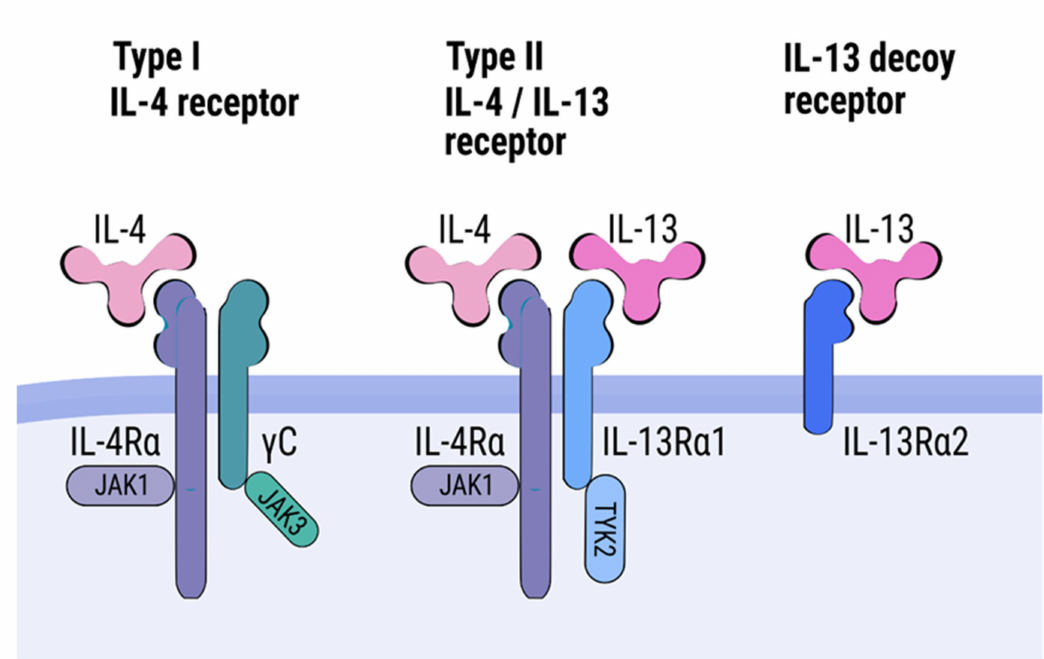
Figure 1. IL-4 receptor alpha (IL-4R α ) constitutes subunits of two heterodimeric receptors, named type I and type II receptors. The type I receptor, composed of IL-4R α and common cytokine receptor γ -chain ( γ c), interacts only with IL-4. The type II receptor is formed from IL-4R α and IL-13R α 1 subunits and interacts with either IL-13 or IL-4. IL-13 also displays the capacity to bind IL-13R α 2, which is regarded as a decoy receptor. A binding of a ligand by type I and II receptors results in an activation of Janus family kinases (JAK1, JAK2, and JAK3) followed by phosphorylation of a signal transducer and activator transcription 6